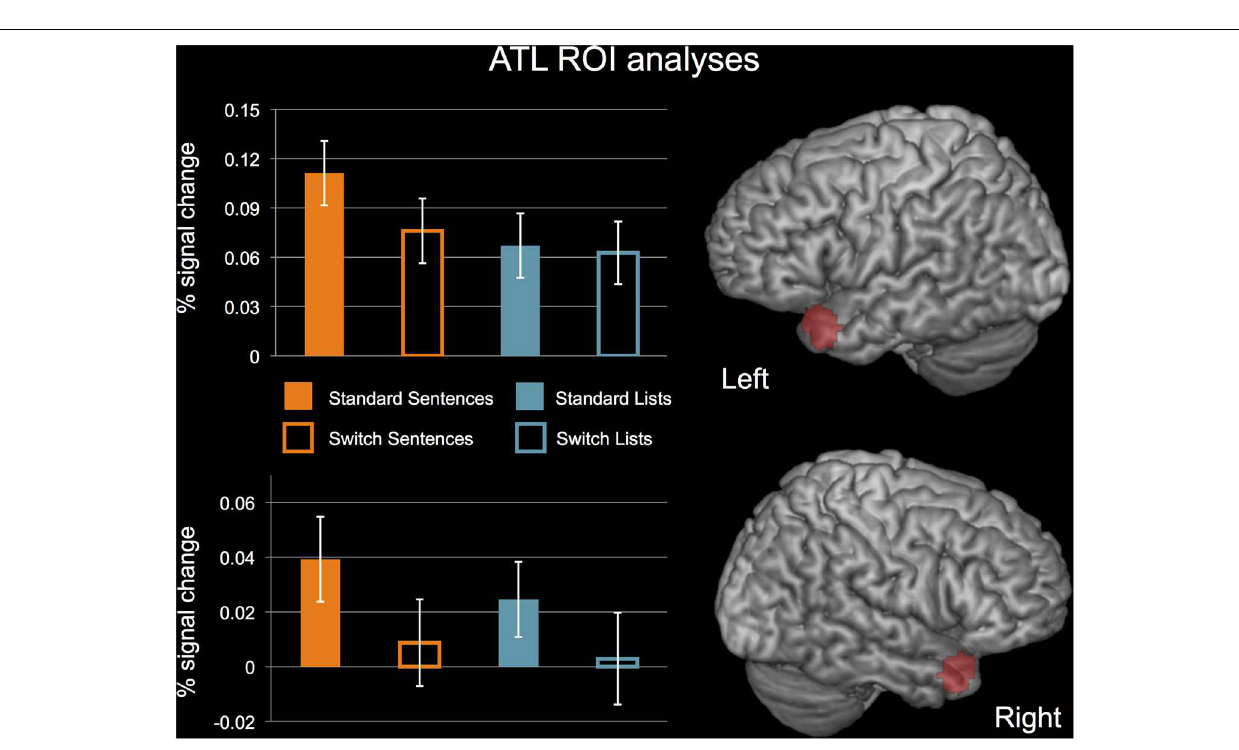
FIGURE 7 | ROI analyses for the left and right ATL. N = 20. Error bars indicate standard error of the mean. See text for details of statistical